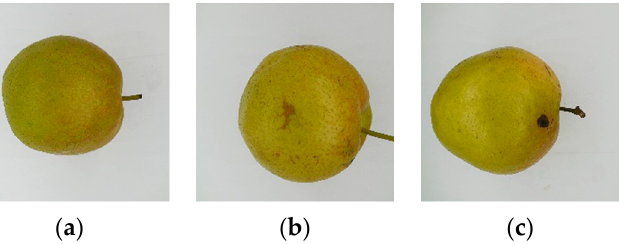
Figure 1. “Yuluxiang” pear. ( a ) Intact sample; ( b ) Russeting sample; ( c ) Cankered sample.